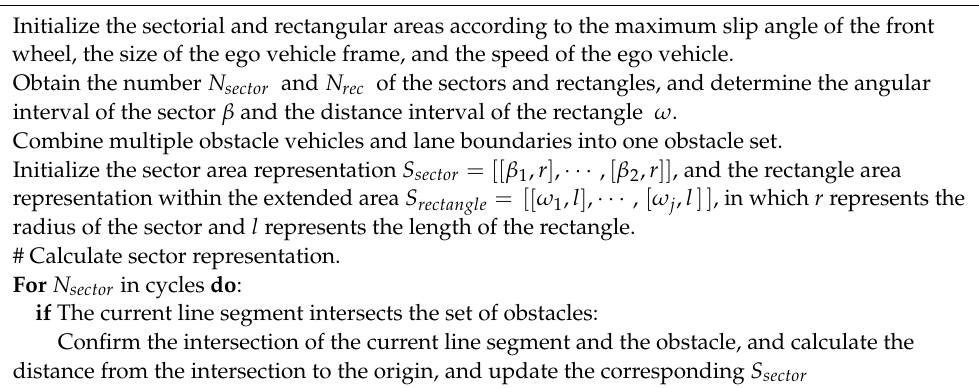
Algorithm 2. Obstacle input representation